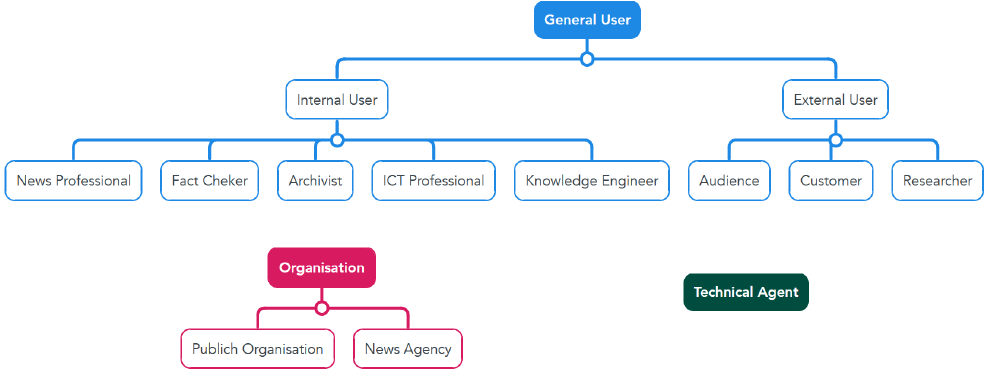
Figure 1. Stakeholder